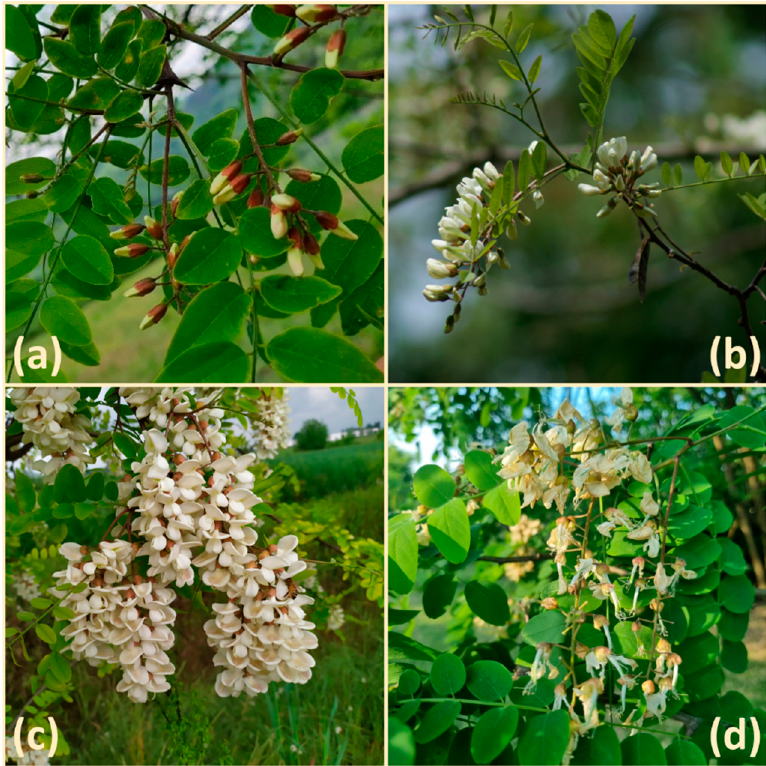
Figure 2. Main flowering stages of black locust: ( a ) BBCH59 ( b ) BBCH61 ( c ) BBCH65 ( d ) BBCH67.